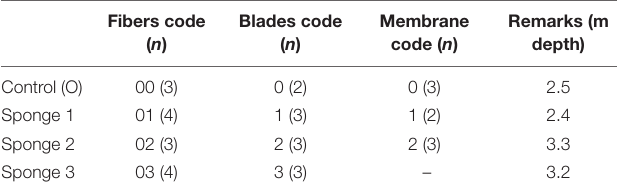
TABLE 1 | Extraction durations and number of installed SPME devices (fibers, blades, and membranes) for each of the three replicate Sarcotragus foetidus specimens and the control